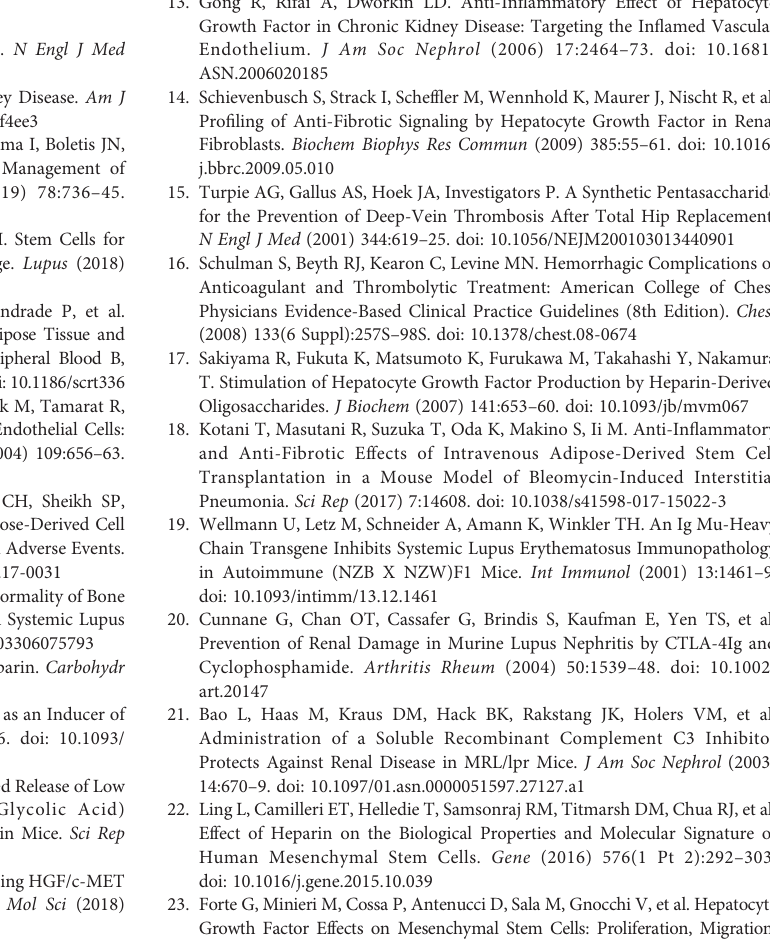
Supplementary Figure 1 | Experimental protocol. 20-week-old female NZB/W F1 mice were randomized to receive saline, hASCs alone and hep-hASCs and they were followed for a further 6 weeks. Mice were euthanized and blood, urine and kidneys were collected for clinical, serological, and histological analysis. ASCs, adipose-derived mesenchymal stem cells. Supplementary Figure 2 | Correlation of gene expressions in hASCs activated by LMWH. Correlation of CXCR7 mRNA expression levels with CXCL12 mRNA expression levels in hASCs. (N=24). Supplementary Figure 3 | Evaluation of therapeutic effects of ASC on lupus nephritis Comparison of kidney function between NZB/W F1 treated with 1×10 4 hASC (N=12), 5×10 4 hASC, (N=5) and 1×10 4 hep-hASC (N=12). (A) Serum creatinine levels. (B) Serum anti-dsDNA antibody